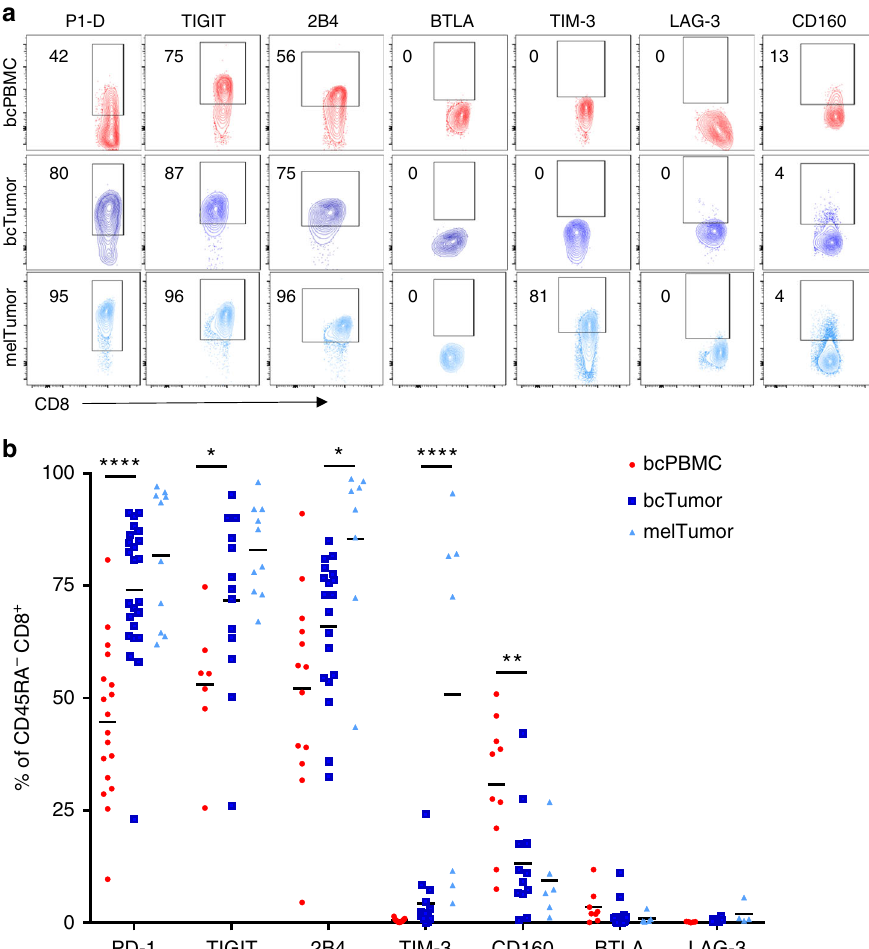
Fig. 2 CD8 + TILs in breast tumors predominantly express checkpoint molecules PD-1, TIGIT, and 2B4. a CD8 + T cells from bcPBMCs, bcTumor, and melTumor were assessed for expression of various checkpoint molecules by fl ow cytometry as shown in representative contour plots. b Graph depicts percentage of non-naive CD45RA − CD8 + T cells that express a given checkpoint molecule. Each symbol represents data from a unique patient sample. Signi fi cance was calculated using one-way ANOVA and Holm – Sidak multiple comparison tests; * p < 0.05; ** p < 0.01; **** p <